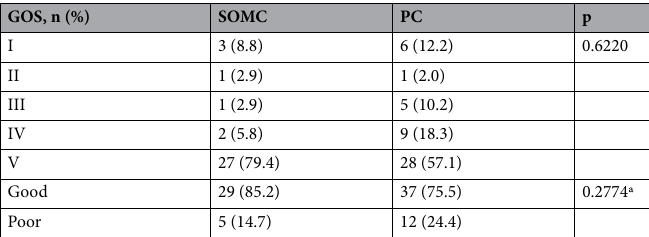
Table 2. Postoperative status at hospital discharge in patients who underwent supraorbital minicraniotomy (SOMC) with eyebrow incision and conventional pterional craniotomy (PC). GOS Glasgow outcome scale. ªp value for good vs. poor GOS. Unpaired Student’s t test and chi-squared test.